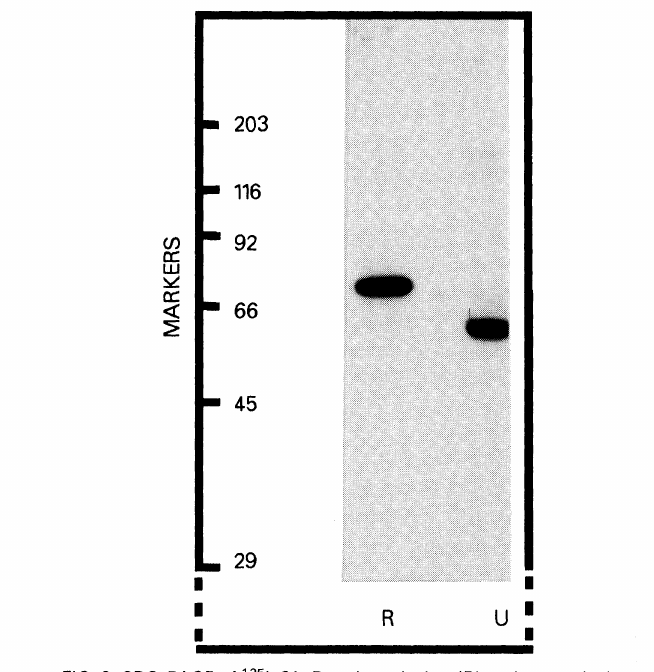
FIG. 3. SDS-PAGE of 1251-ClqR under reducing (R) and non-reducing (U) conditions.